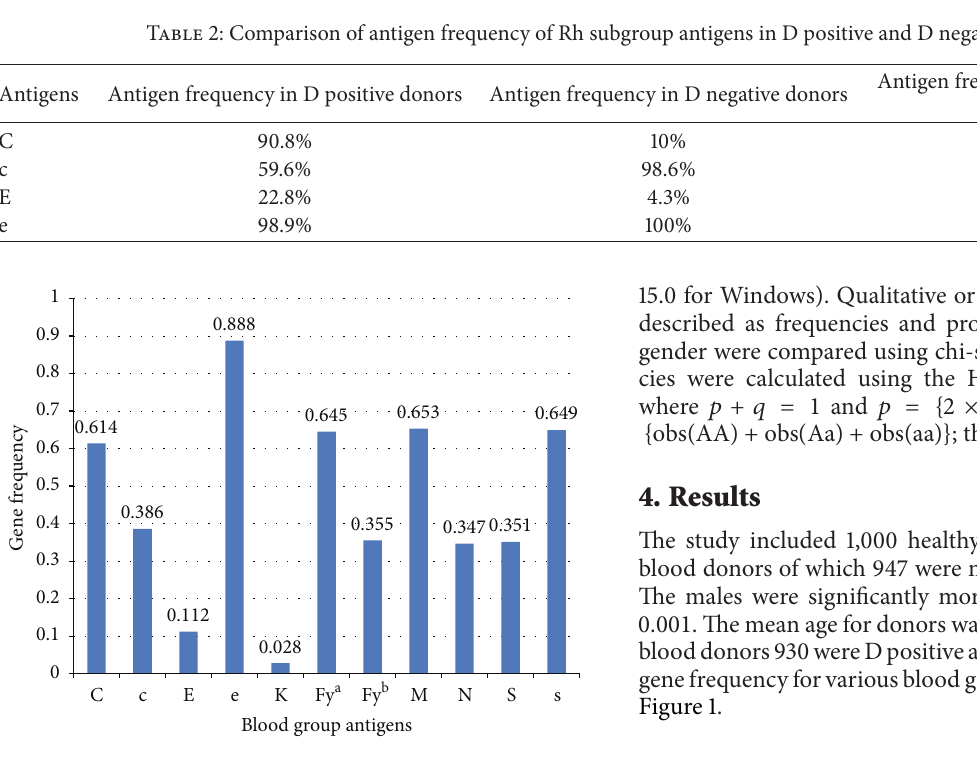
Figure 1: Gene frequency of minor blood group